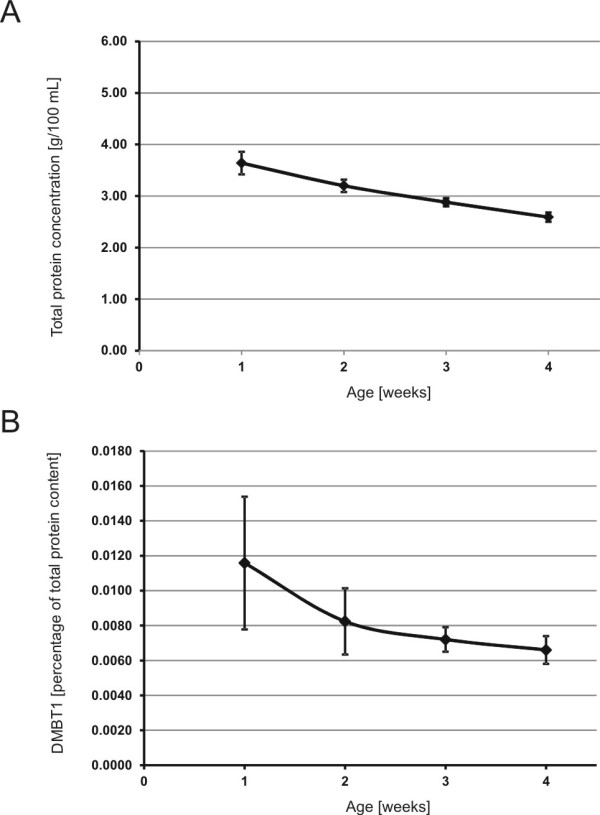
DMBT1 and total protein content. The total protein concentration (mean ± SEM) decreased in the first four weeks after birth (A). B illustrated the percentage of DMBT1 from the total protein content (mean ± SEM) in the first four weeks of life.